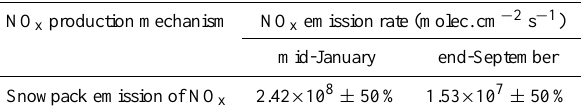
Table 2b. As for Table 2a, but now the rate of NO x emission from the snowpack into the overlying boundary layer. See text for full